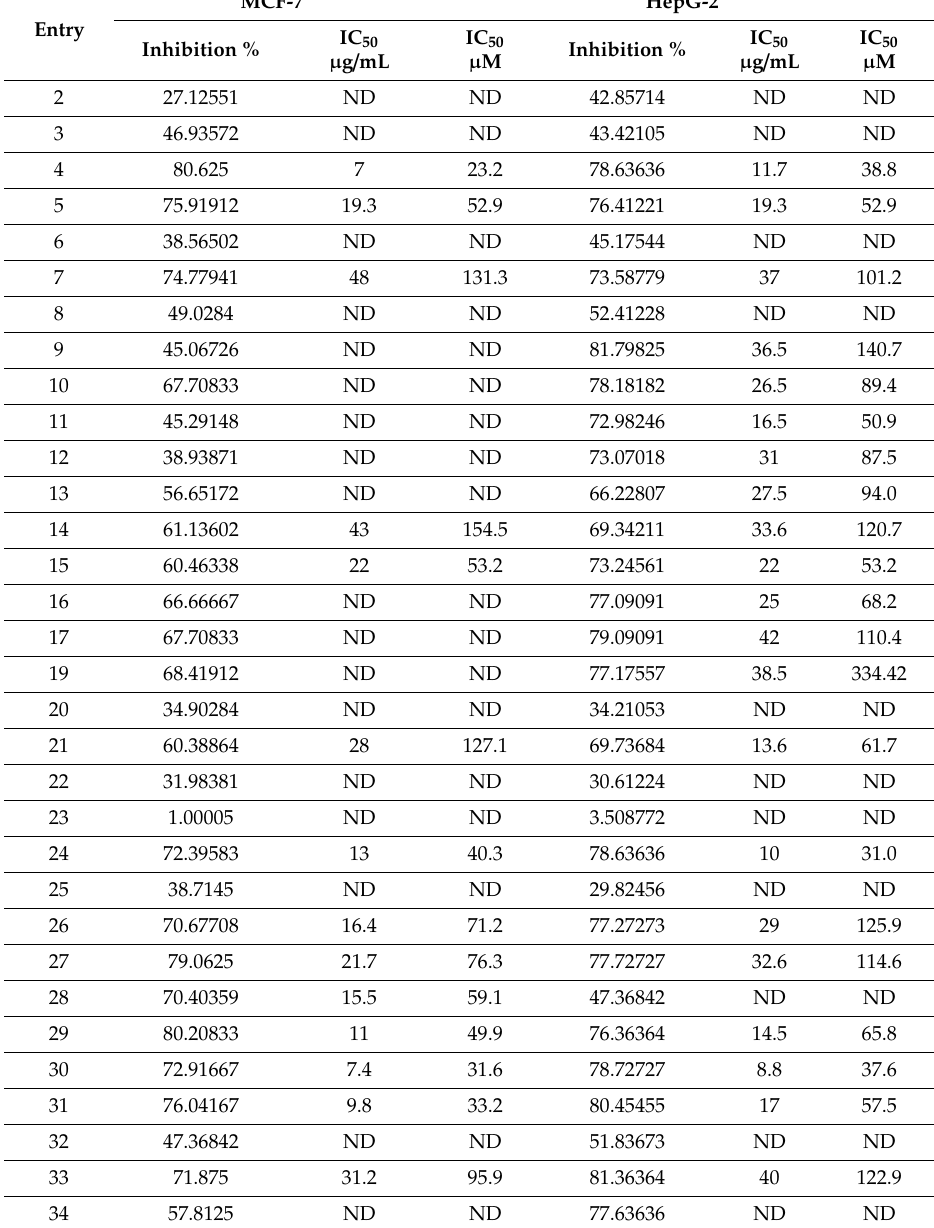
Table 1. The in vitro inhibition % found using (100 µ g / mL) of a single dose and IC 50 in µ g / mL and µ M of the tested compounds on MCF-7 and HepG-2 cell